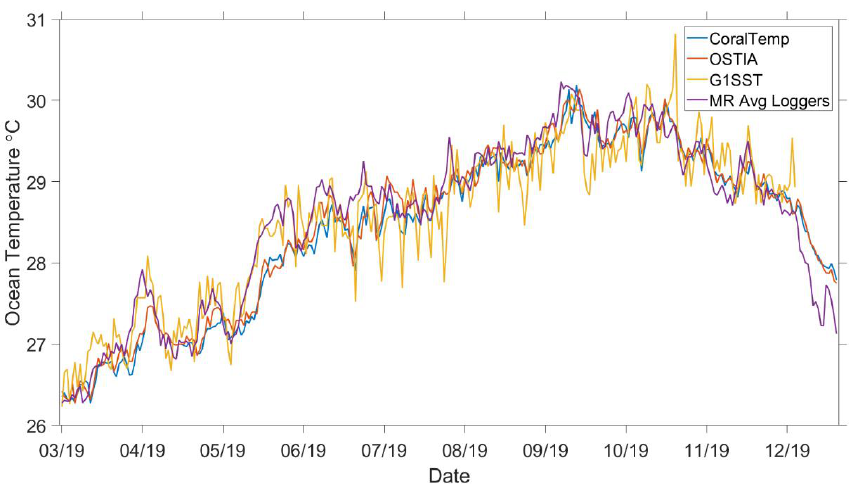
Figure 4. Time series of temperature data from 1 March 2019–24 December 2019 of the three remote sensing datasets (CoralTemp, G1SST, and OSTIA), and the averaged in situ loggers for Margarita Reef. Ocean temperature seasonality was also explored for Cayo Enrique and Cayo Mario for